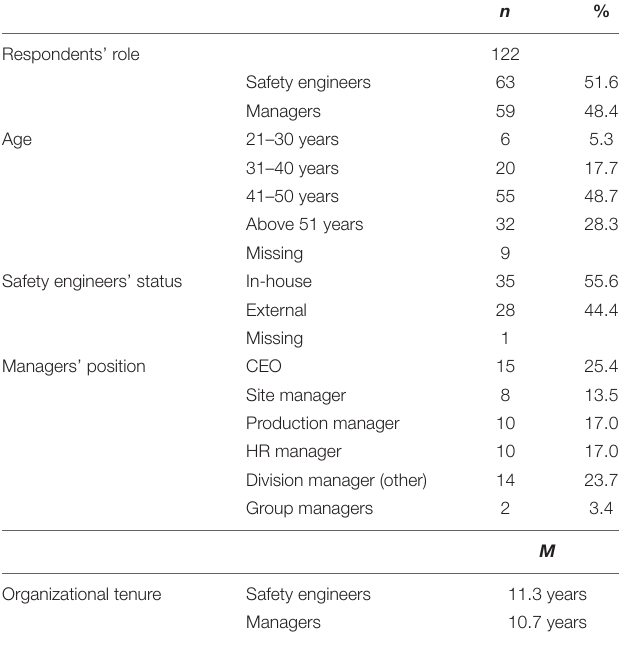
TABLE 1 | Description of respondents’ role, age, employment status, or